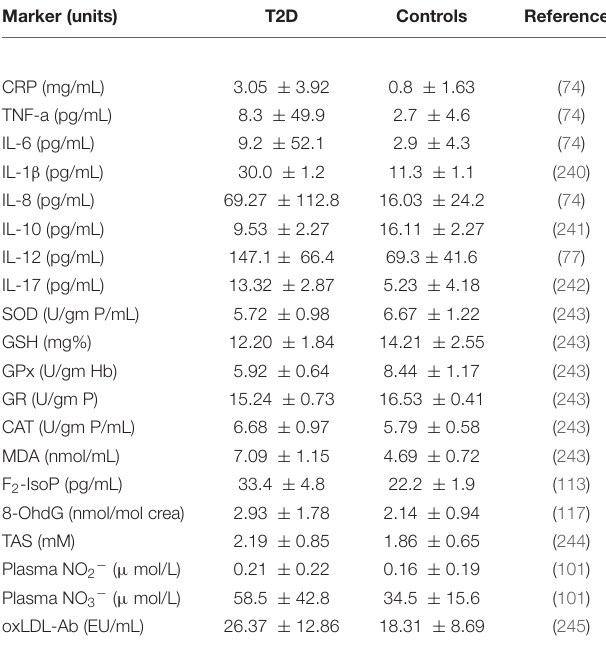
TABLE 1 | Reference levels of markers of inflammation and oxidative stress in patients with type 2 diabetes and controls. Marker